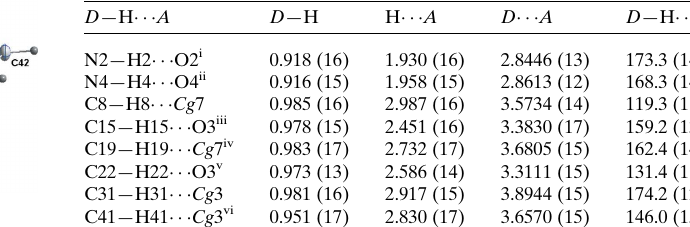
Figure 1 The asymmetric unit with labeling scheme and 50% probability displacement ellipsoids. The C—H (cid:2)(cid:2)(cid:2) (cid:2) (ring) interactions are shown by dashed